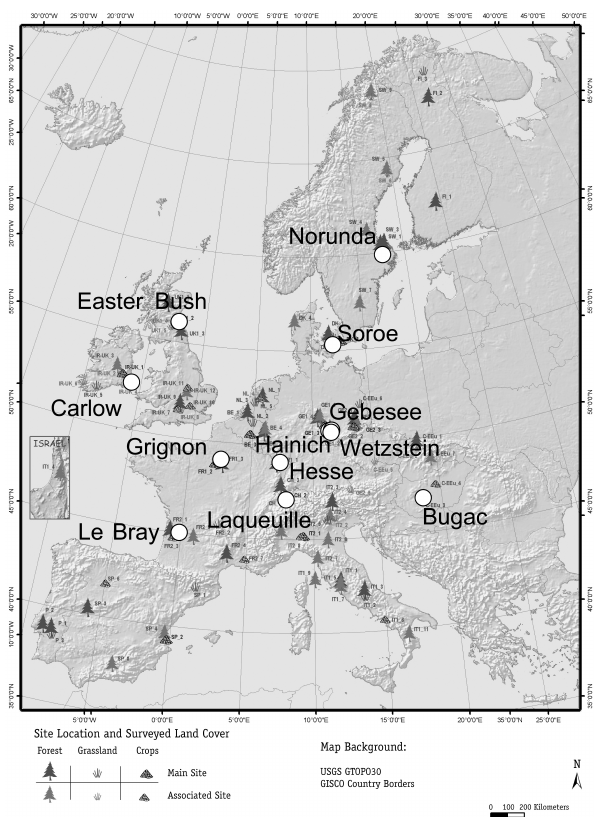
Fig. 1. Main and associated eddy covariance tower sites of Car- boEurope IP, names indicate verification sites with intensive soil analyses (taken from Schrumpf et al.,